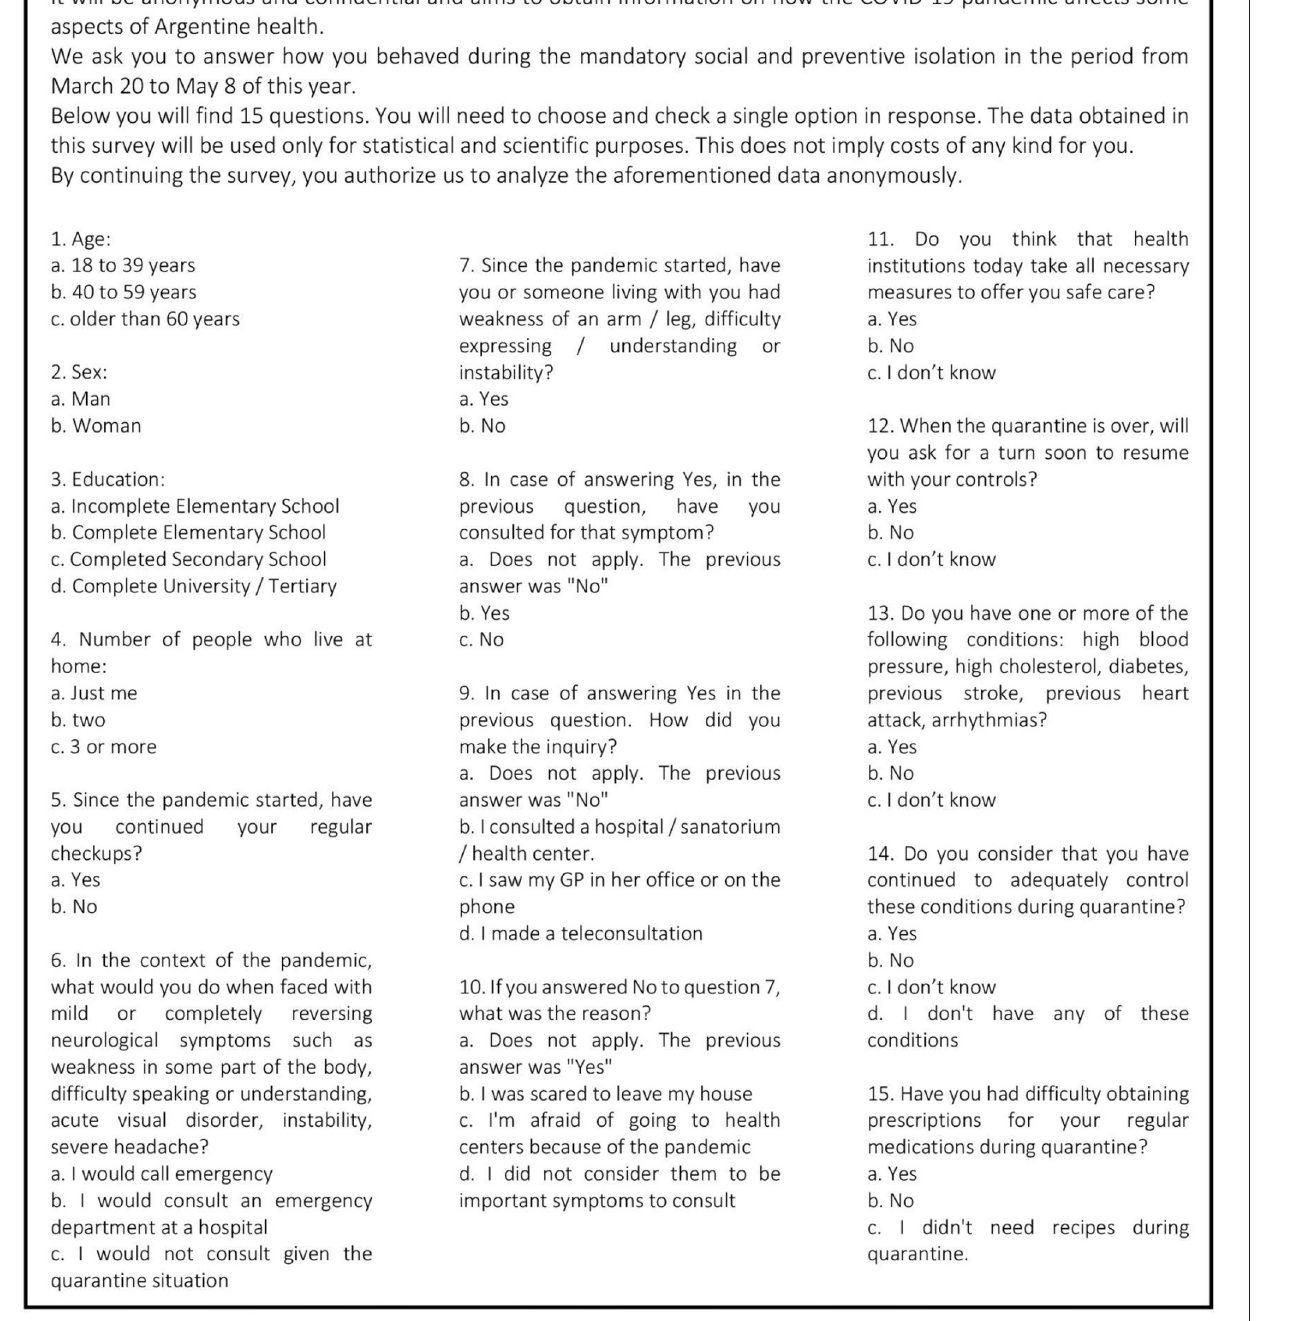
analysis, categorical variables are presented as frequencies and percentages. Normal distribution was checked using Shapiro- Wilk test. For comparisons between groups we used chi